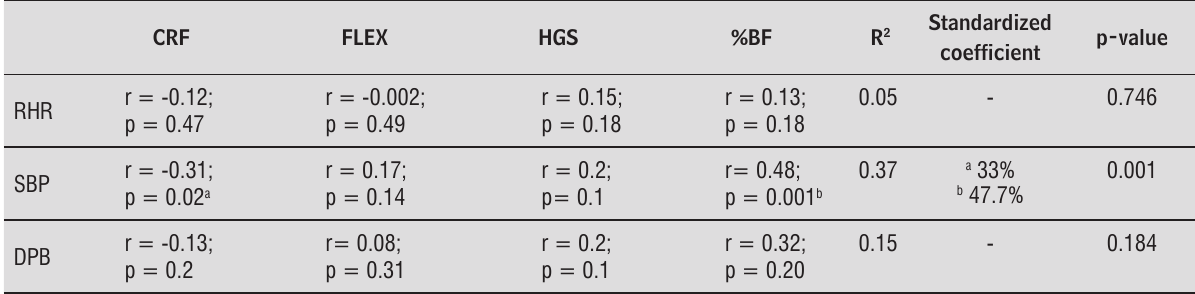
Table 2 – Relationship between indicator variables of physical fitness and health in the women